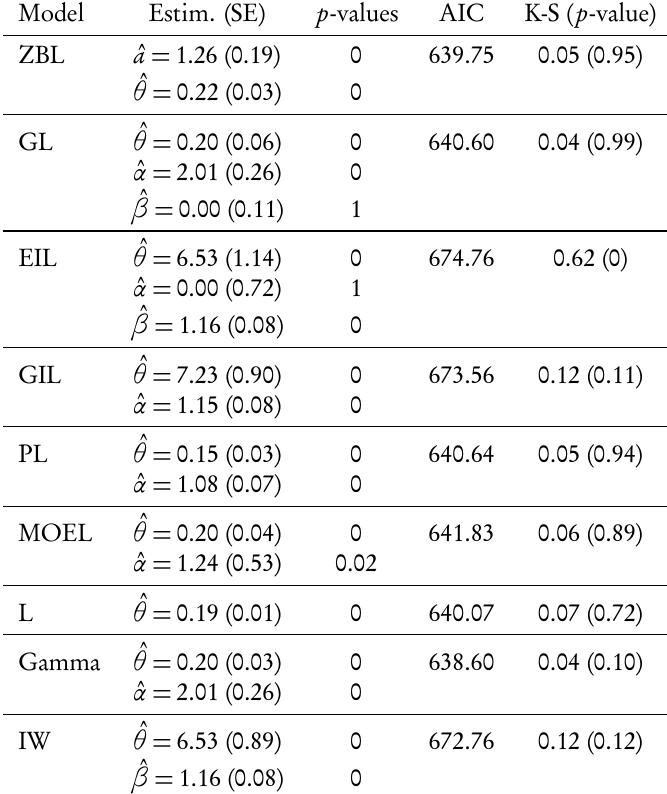
The estimated parameters, the corresponding standard errors, and the goodness-of-fit statistic for the models fitted to the waiting times of 100 bank customers